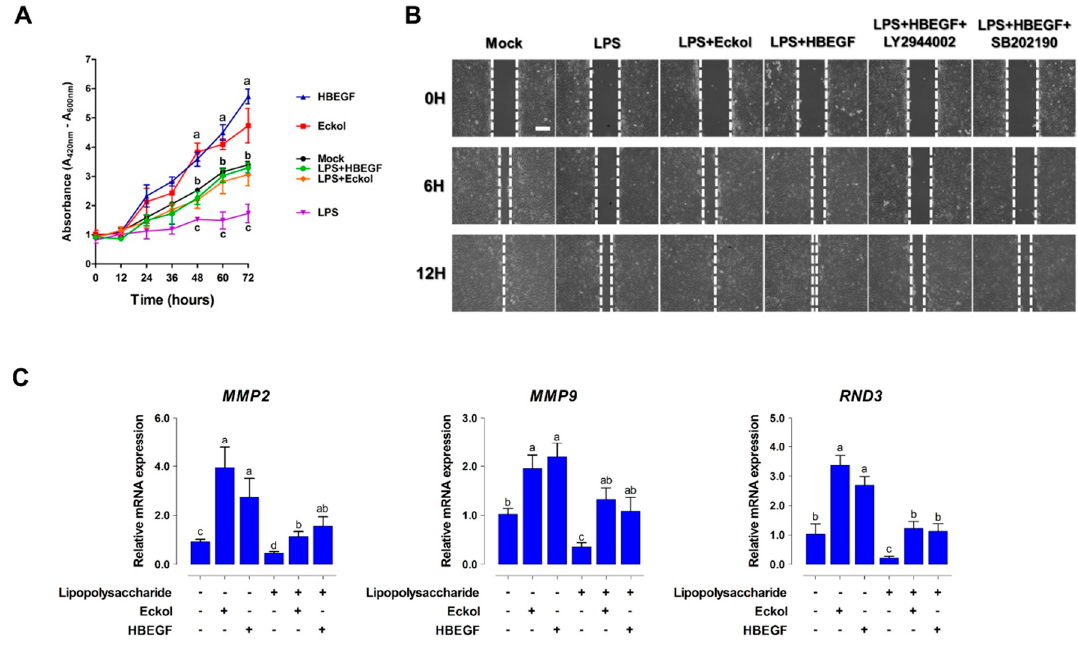
Figure 6. Eckol promotes intestinal wound healing through HBEGF. ( A ) Cell proliferation was assessed at 12 h, 24 h, 36 h, 48 h, 60 h, and 72 h using the water-soluble tetrazolium-1 assay (n = 3) ( B ) Migration was assessed at 0 h, 6 h, and 12 h using a wound-healing assay (n = 3) ( C ) Relative expression levels of cell migration-related genes were analyzed using qRT-PCR in eckol- and HBEGF-treated IPEC-J2 cells under LPS challenge with or without PI3K / AKT (LY2944002) and P38 (SB202190) inhibitors. Error bars indicate standard error of triplicate analyses. Lower-case letters indicate significant di ff erences ( p < 0.05) among treatments, based on Duncan’s multiple range test.